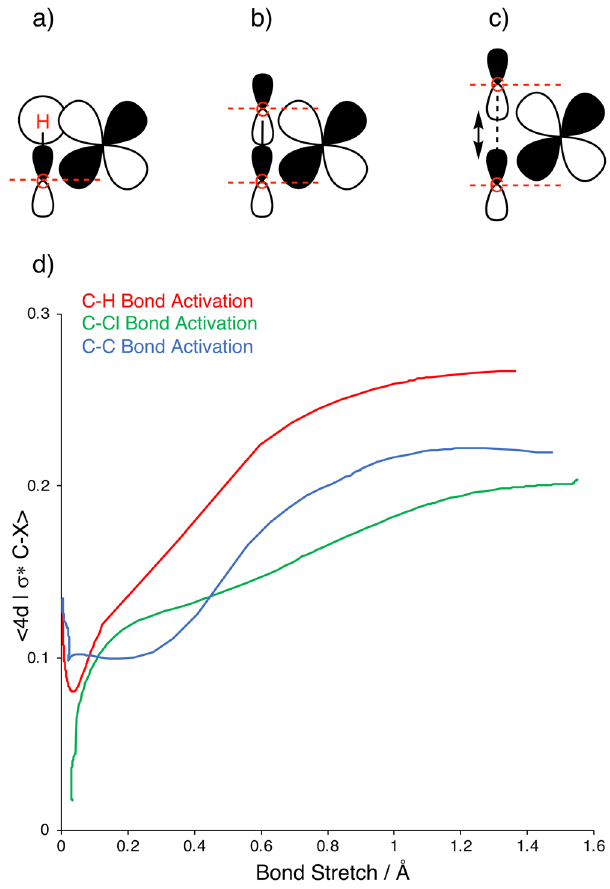
of ( a ) a C–H bond; ( b ) a C–C bond; ( c ) an elongated C–C bond (dashed red lines represent the nodal plane of the carbon 2p atomic orbital); and ( d ) overlap integral of the backbonding interaction between Pd 4d π and the arylic C–X antibonding σ * C–X orbitals along Pd + C 6 H 5 –X oxidative addition reactions, computed at ZORA-